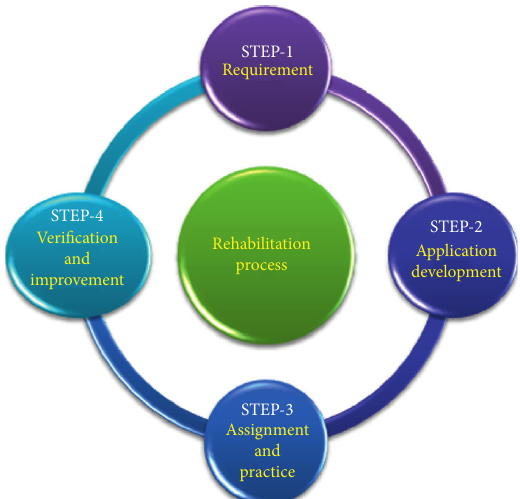
Figure 1: Cycle of the rehabilitation process and associated precise protocol development and